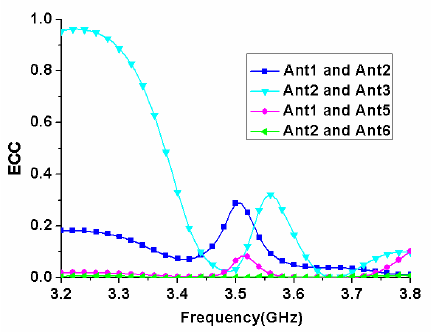
Figure 15. The simulated envelope correlation coe ffi cient (ECC) of the proposed MIMO antenna array.